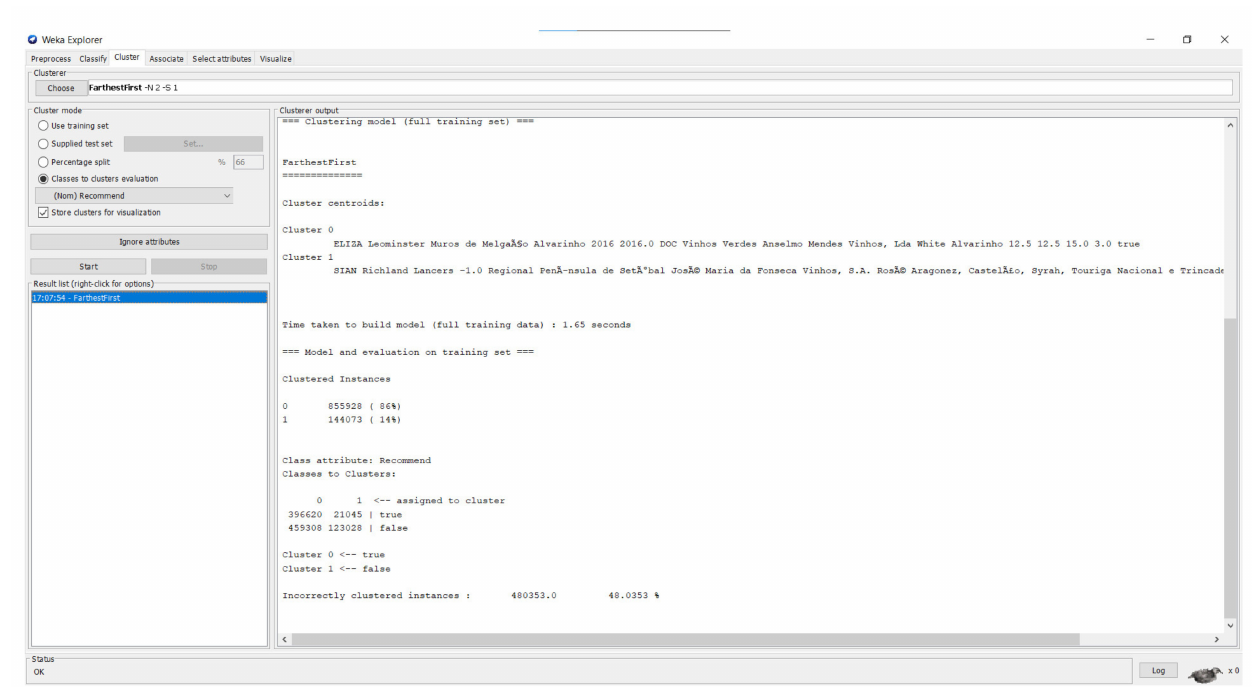
Figure 4. Results of the Farthest First algorithm in Weka.